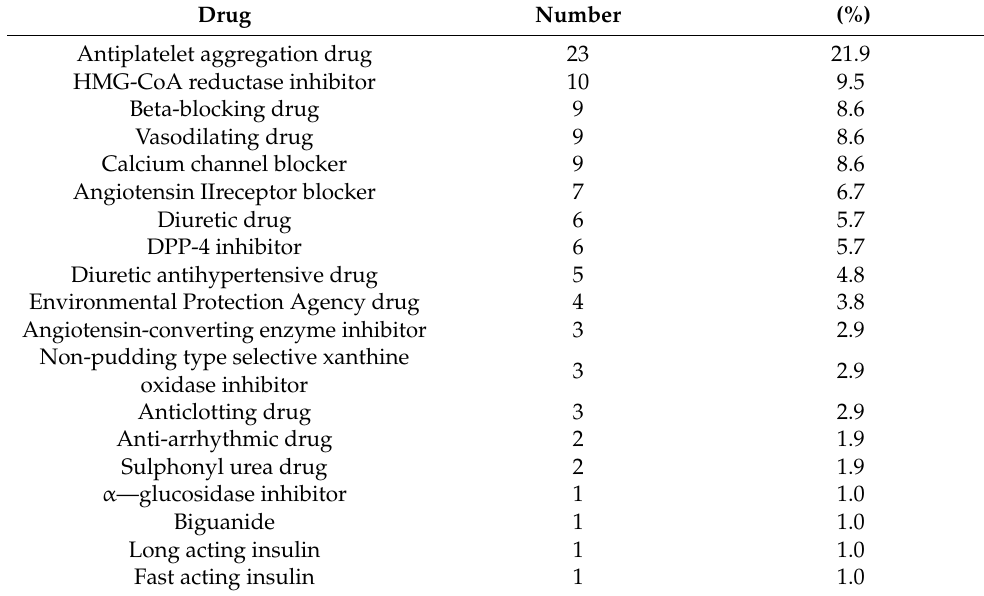
Table 3. Cardiovascular disease and medications (at the time of hospitalization) ( n =